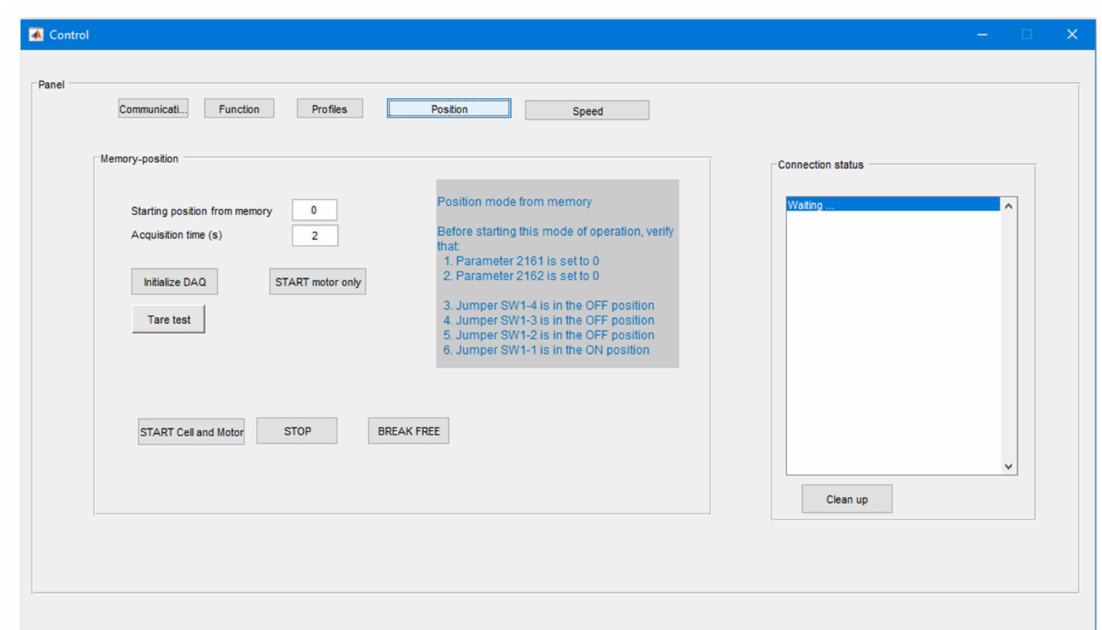
Figure 14. Control application: speed mode operation.